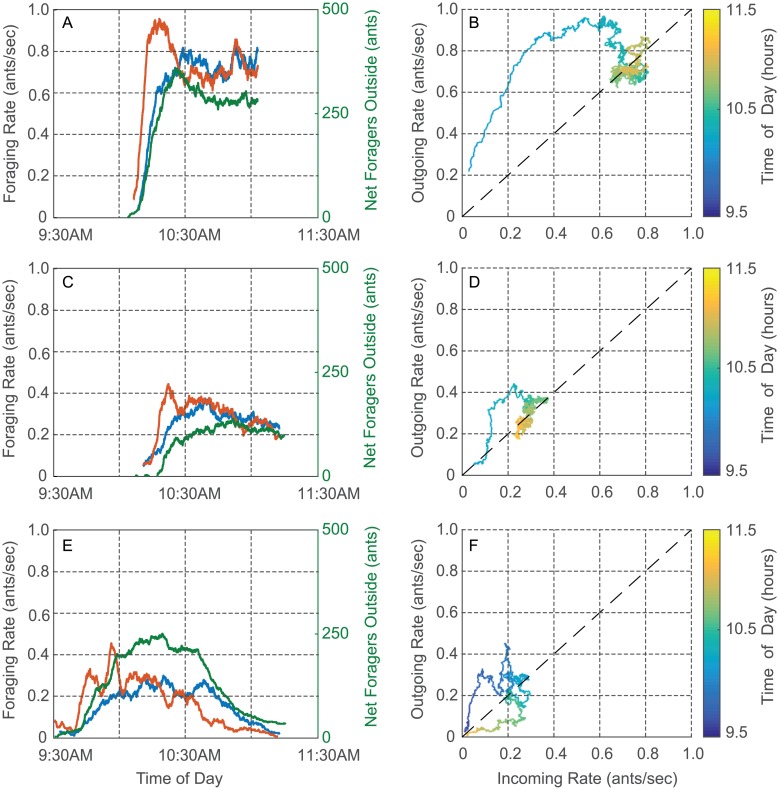
Plots of foraging rate data.Time series plots show incoming foraging rate rin (blue), outgoing foraging rate rout (red), and cumulative difference between the number of incoming and outgoing foragers (green) versus time of day. Input-output plots show rout(t) versus rin(t) with the color scale representing time of day t. A) and B) Colony 664 on August 27, 2015. C) and D) Colony 664 on August 31, 2015. E) and F) Colony 863 on September 1, 2015.